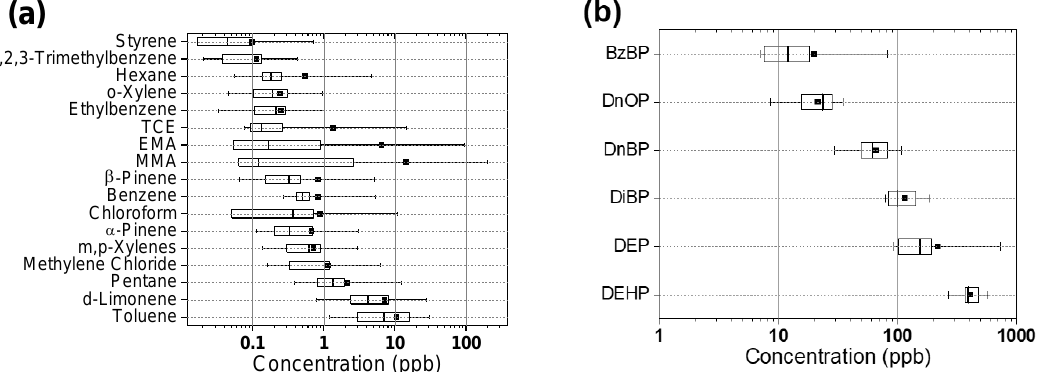
Figure 1. Boxplots of 18 VOCs and 6 phthalates measured in 20 nail salons. ( a ) shows a boxplot of 18 VOCs detected from at least 13 out of 20 nail salons. Tetrachloroethylene (TCE); ethyl methacrylate (EMA); and methyl methacrylate (MMA). ( b ) shows a boxplot of six phthalates detected from all 10 nail salons. Phthalates are Di(2-Ethylhexyl) Phthalate (DEHP); Di-n-octyl phthalate (DnOP); Diisobutyl phthalate (DiBP); Diethyl phthalate (DEP); Di-n-butyl phthalate (DnBP); Benzylbutyl phthalate (BzBP). Mean and median values are shown as squares and straight lines. Left and right edge of the boxes represent 25th and 75th percentiles. Whiskers represent minimum and maximum values.